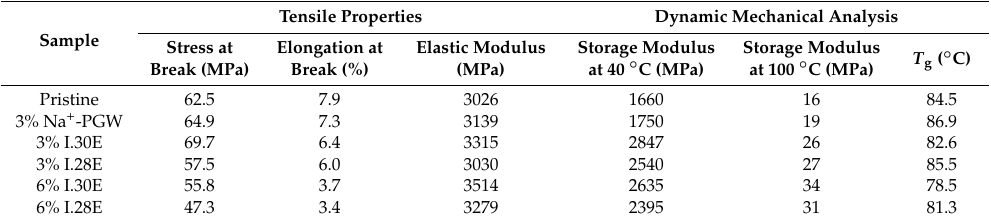
Table 3. Tensile and thermo-mechanical properties of glassy epoxy–clay